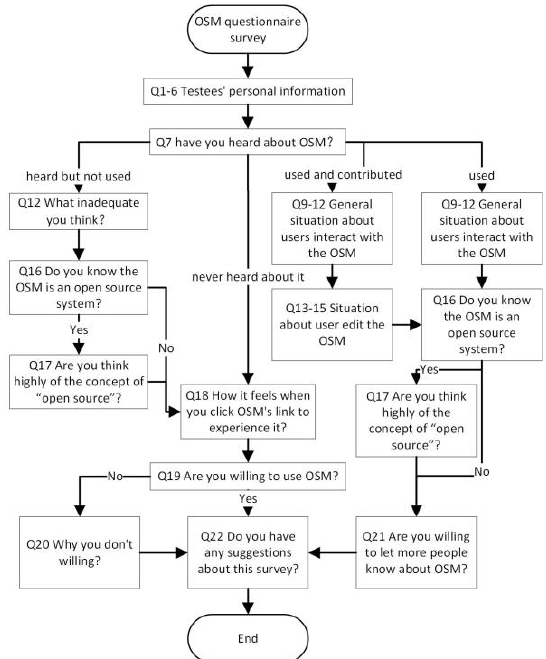
Figure 6. The flow chart of questionnaire that people fill in